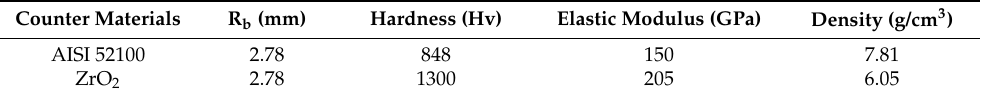
Table 3. Physical properties of the counter materials.